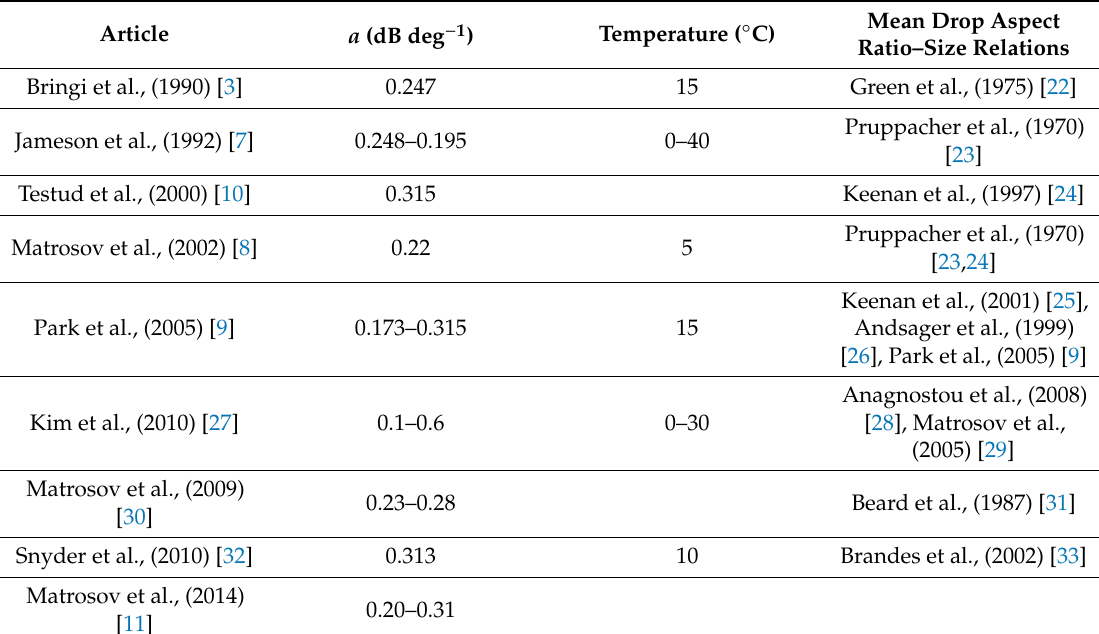
Table 2. X band ratios a from scattering simulations and